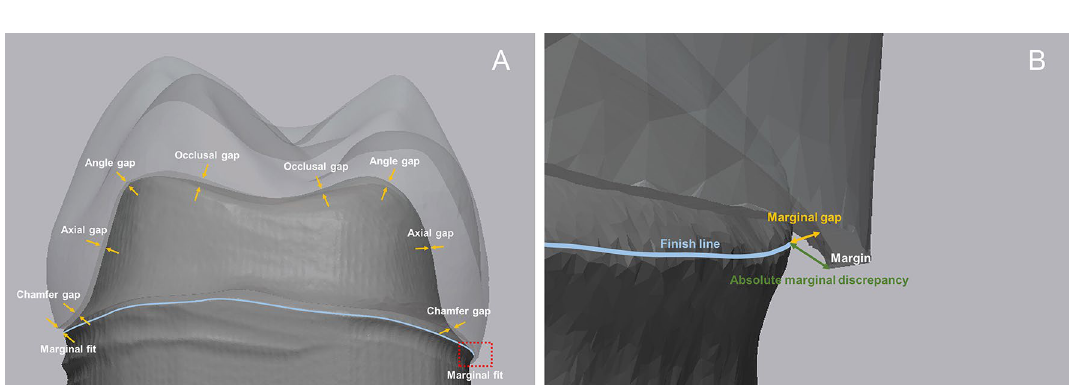
Figure 3. Schematic of the measurement regions of the marginal and internal fit. ( a ) Marginal and internal fit, ( b ) marginal